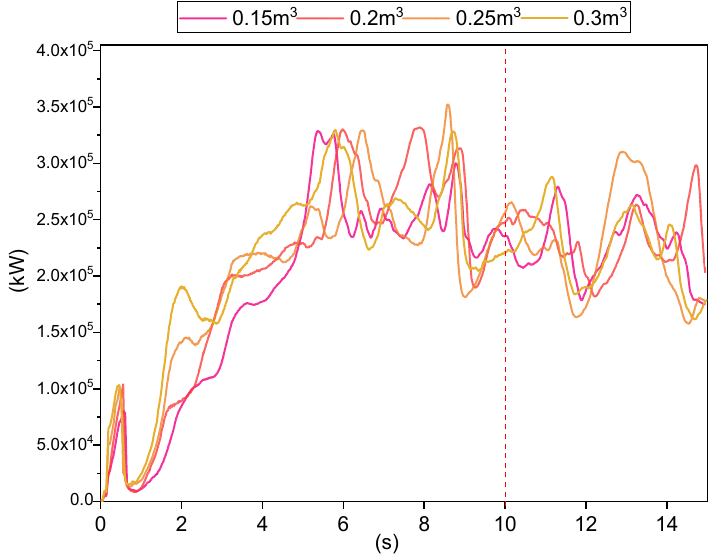
Figure 3. Mesh sensitivity analysis of fire suppression by water.